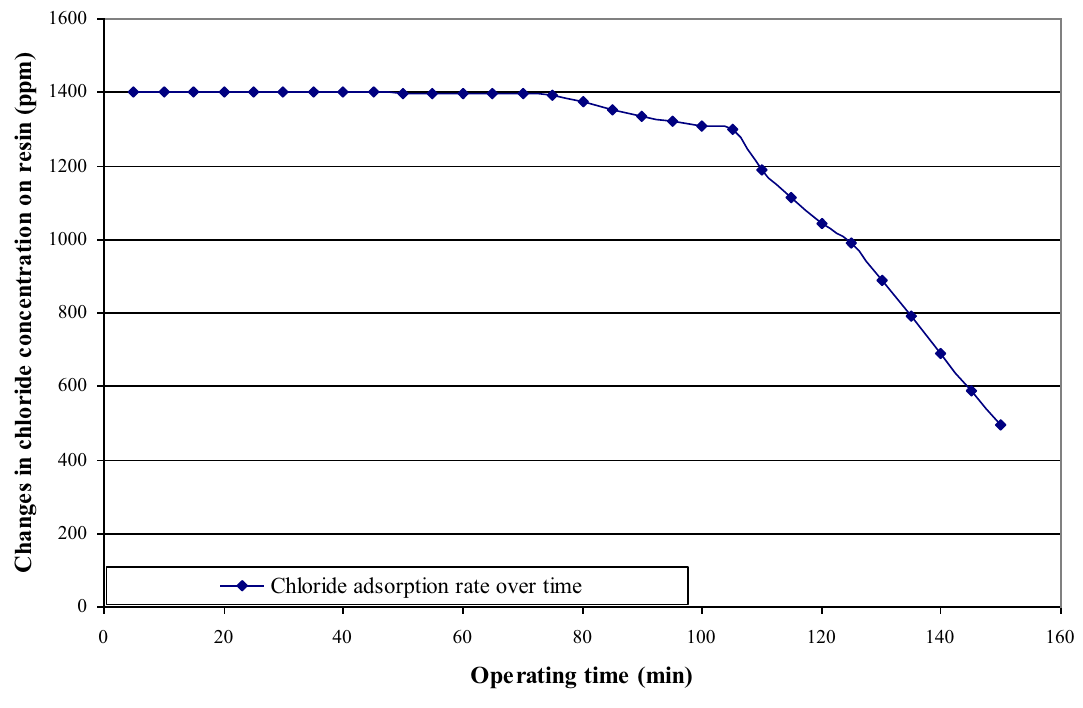
Fig. 4 Resin bed saturation time in terms of chloride concentration